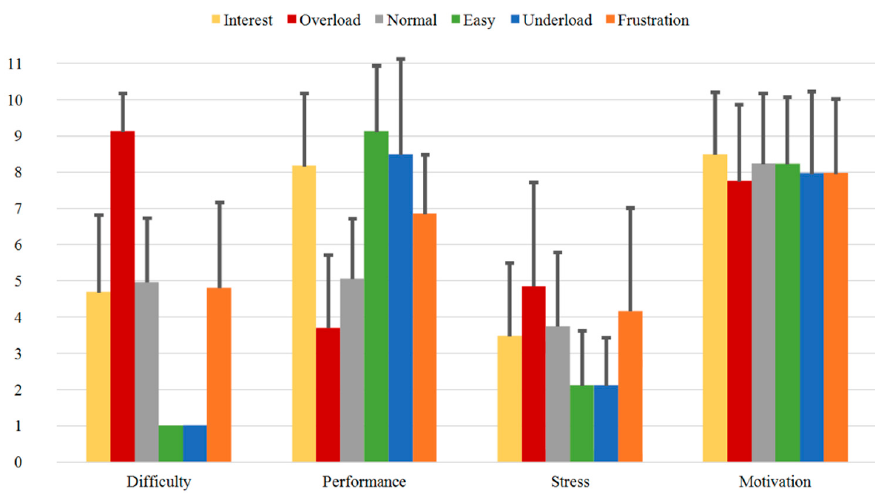
Figure 15. Direct Questions of Group B3 for all the sequences with mean values.